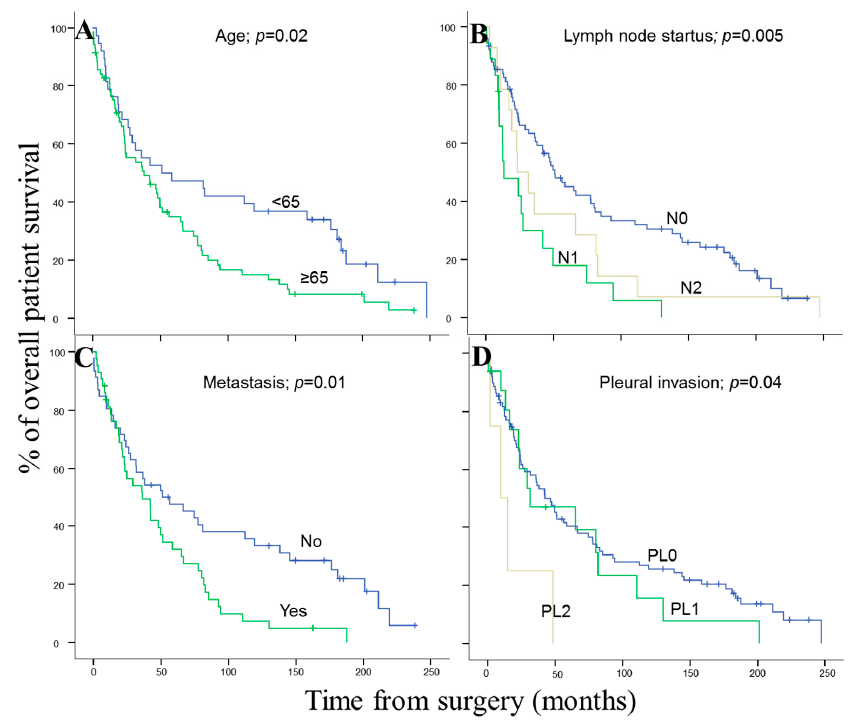
Figure 3. Clinic, histopathologic and biologic-disease characteristics of pulmonary SCC patients which showed a significant impact on overall survival in the univariate analysis: ( A ) Age, ( B ) lymph node status, ( C ) presence of distant metastasis and ( D ) pleural invasion. Survival information was available for 103